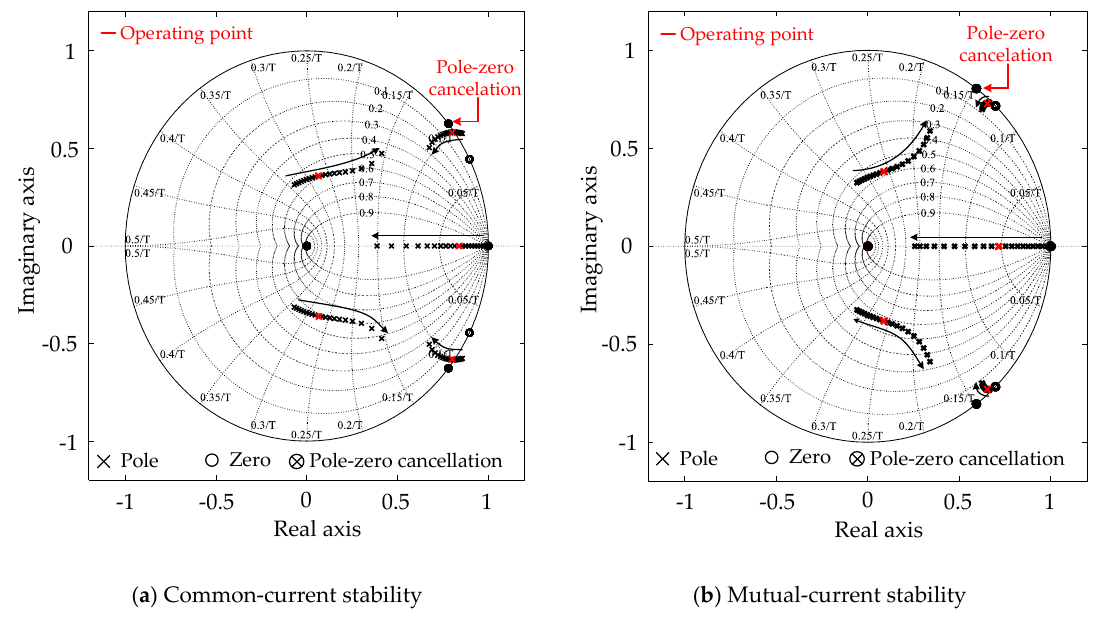
Figure 7. Pole-zero movement of G com_PI ( z ) and G mut_PI ( z ) under k p variation with n = 2.